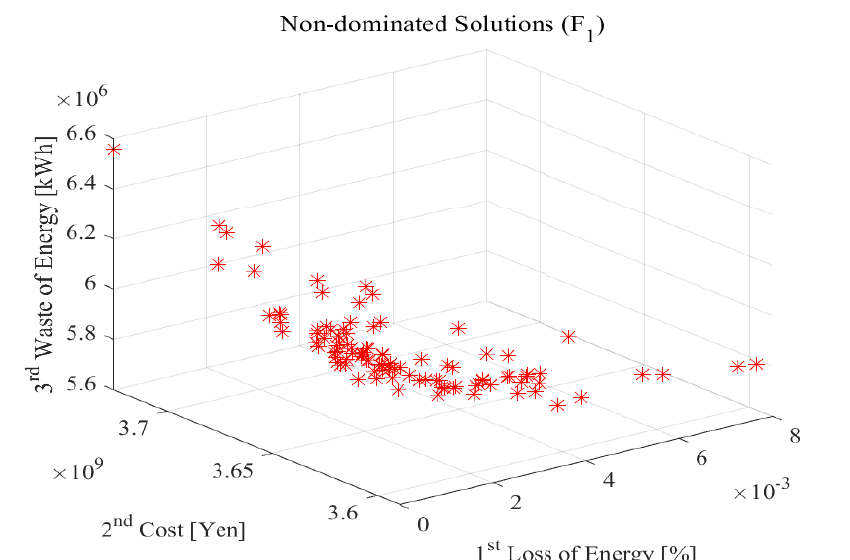
Figure 6. Failed Pareto front of Case 3.